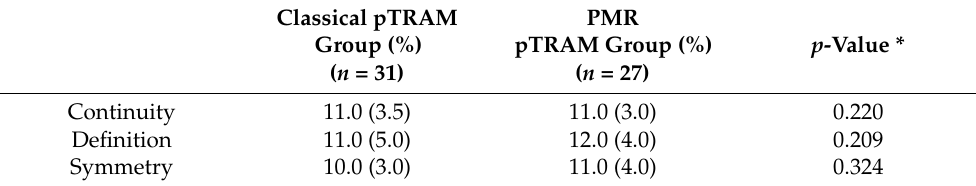
Figure 10. A 54-year-old patient who underwent immediate reconstruction of the right breast using the entire rectus muscle. ( Top ) Preoperative frontal and three-quarters oblique view. ( Bottom ) Frontal and three-quarters oblique view 15 months post-operative. In the aesthetic evaluation of the IMF, continuity, definition, and symmetry were given scores of 3.7, 4.3, and 4, respectively. Table 4. Aesthetic evaluation of the inframammary